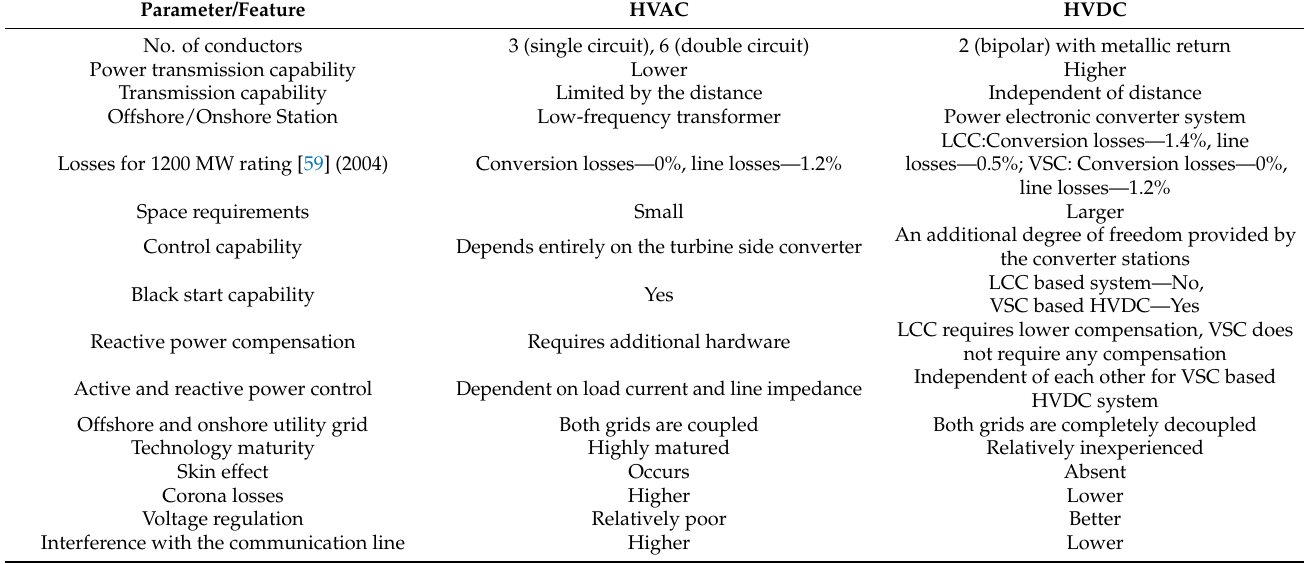
Table 2. Performance comparison of HVAC and HVDC transmission modes [34,49,51,59,60].